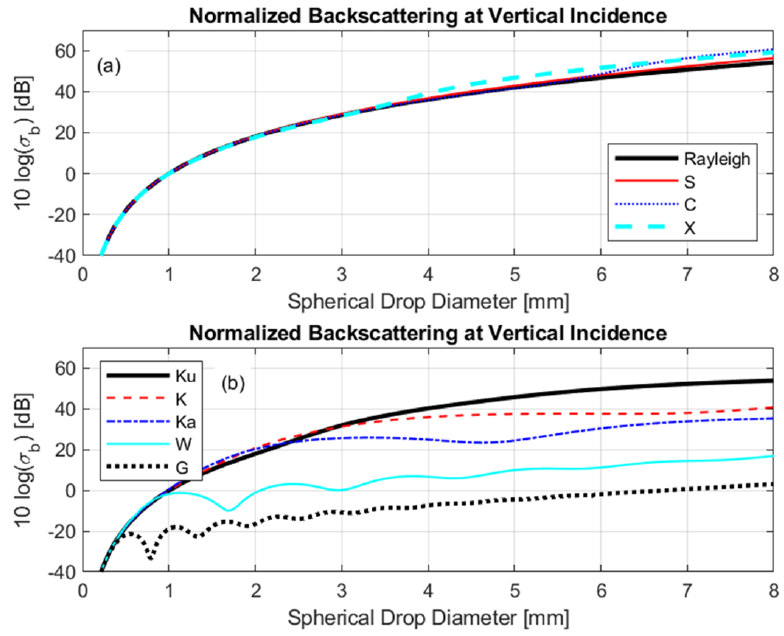
Figure 3. Extinction cross-section at vertical incidence expressed in decibel units 10𝑙𝑜𝑔[𝜎 𝑏𝜆 (𝐷 𝑒𝑞 )] verses spherical raindrop diameter 𝐷 𝑒𝑞 for radar S-, C-, X-, Ku-, K-, Ka-, W-, and G-bands. The high diameter resolution PyTmatrix raindrop backscattering and extinction